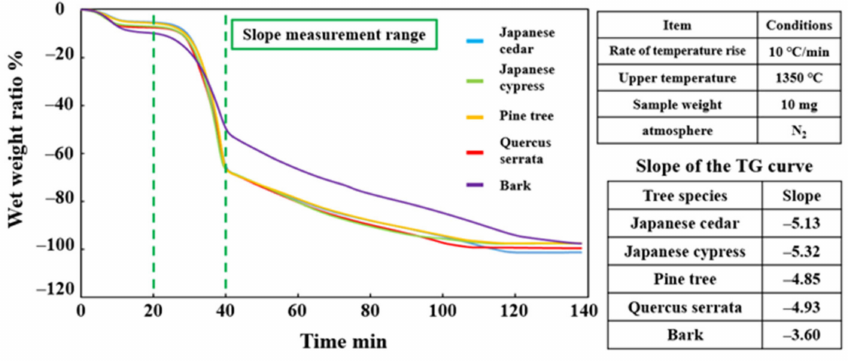
Figure 12. Results of thermal analysis.